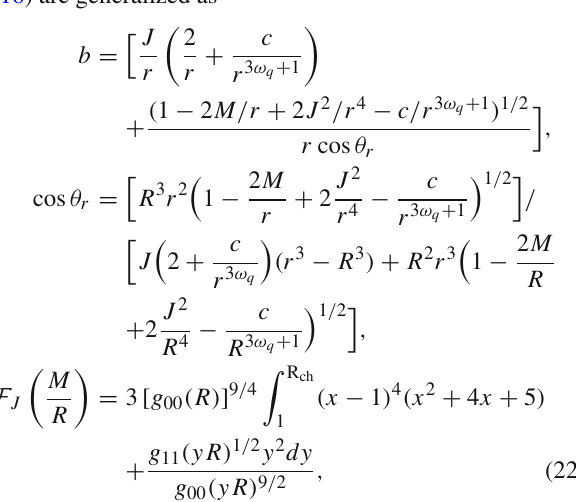
Fig. 6 Contour plot for ω q ∈] − 1 , − 0 . 65 [ . On the y axis are reported the excluded values of c due to the creation of a naked singularity (white part) and, on the right, the values of F ( R ph ) . It can be also seen the values of the parameter c , for which F ( R ph ) ∼ O ( 10 4 –10 5 ) , that are excluded by the energy deposition bounds